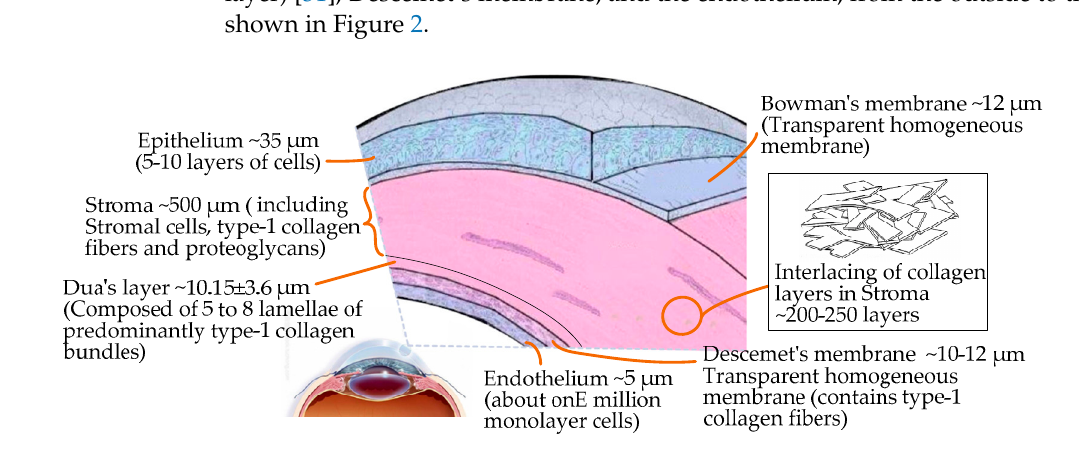
Figure 2. Microscopic layered structure and interior composition of the cornea.